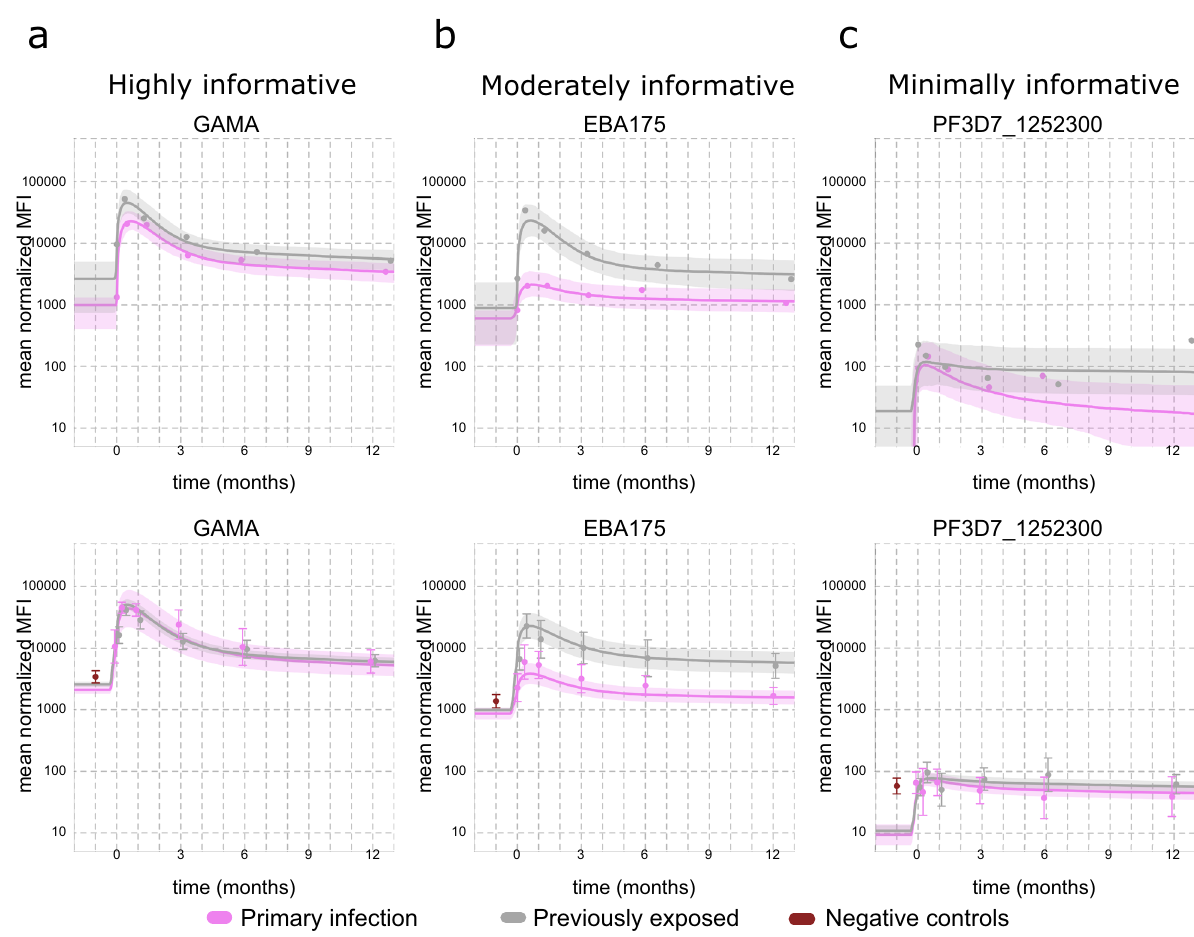
Fig. 5 Individual- and population-level antibody kinetics for the responses to three representative antigens (GAMA, EBA175, and PF3D7_1252300) in primary infected and previously exposed individuals. The antibody kinetic model was fi tted separately to data on each antibody response measured in 240 longitudinally collected samples from 65 unique study participants. The major antibody kinetic patterns observed were: a a rapid increase and decay following infection with limited differences between individuals with and without prior exposure, b a rapid increase and decay following infection but with substantial differences between individuals with and without prior exposure, and c a limited boosting and decay following infection with or without differences between individuals with or without prior exposure. The top row displays the antibody kinetics for two representative study subjects who were either primary infected or previously exposed. The dots denote the individual sample antibody reactivity, i.e. median fl uorescent intensity (MFI). The solid lines denote the model predicted antibody boost and decay patterns relative to the collection of the fi rst sample at time t = 0 and the shaded area the 95% credible interval of the prediction. The bottom row displays the geometric mean MFI over time in each exposure group relative to the collection of the fi rst sample at time t = 0. The grey and magenta dots denote the average reactivity in previously exposed and primary infected individuals, respectively, at each sampling time point. The red dots denote average reactivity in negative control samples. The error bars of each point denote the corresponding 95% con fi dence interval (CI). The solid lines denote the model predicted mean boosting and decay in each exposure group and the shaded area the 95%